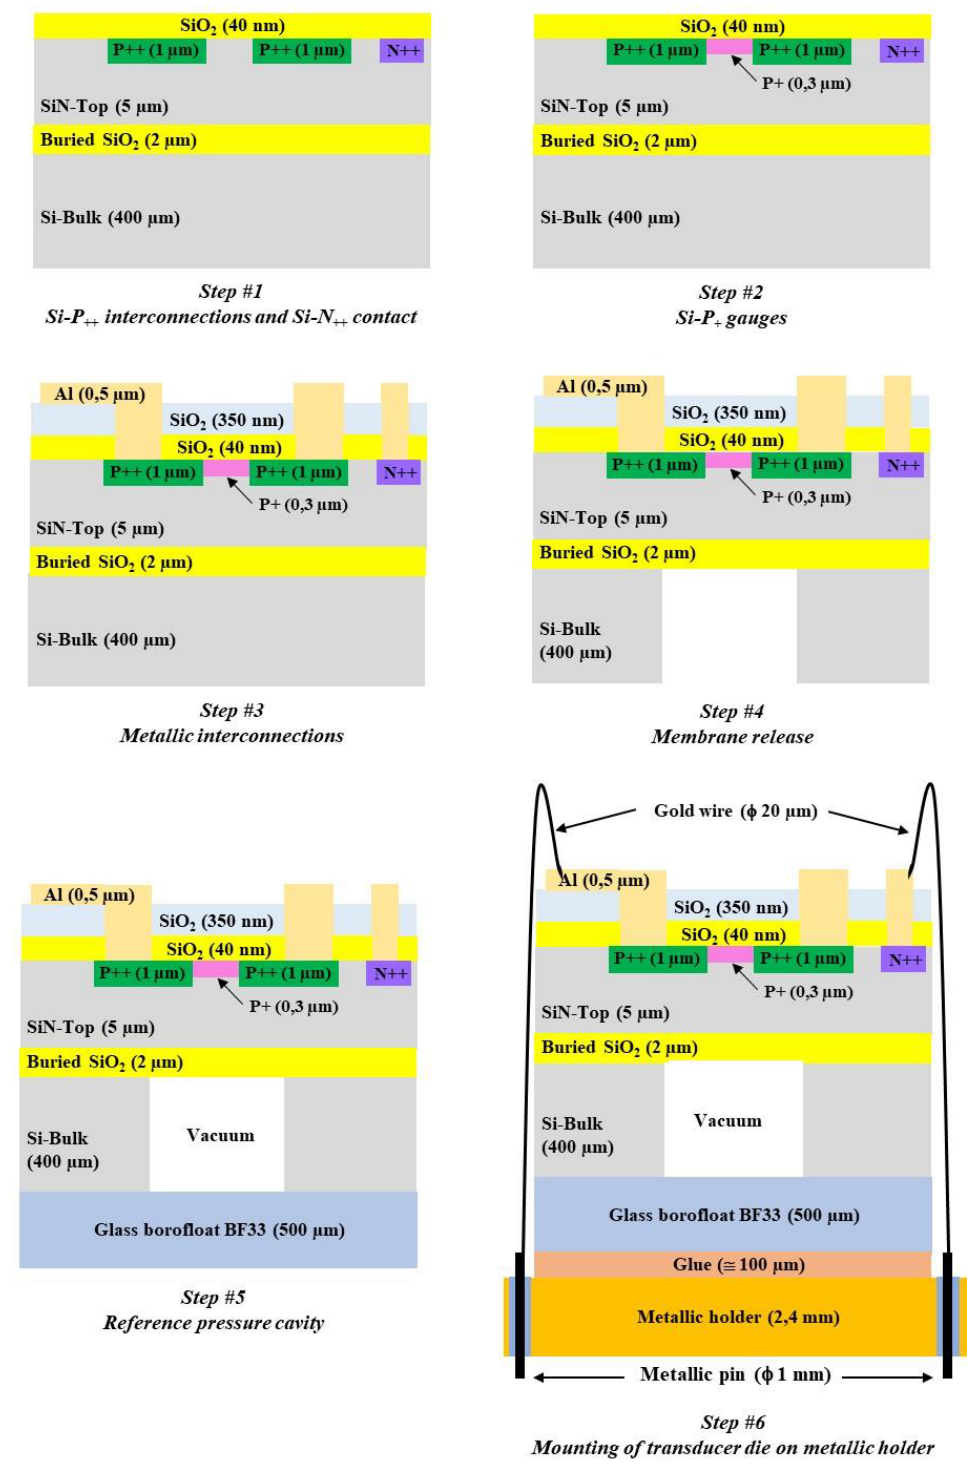
Figure 11. Main steps of the technological flow chart for sensor fabrication. Step #3 is dedicated to the implementation of the metallic interconnections. A 350